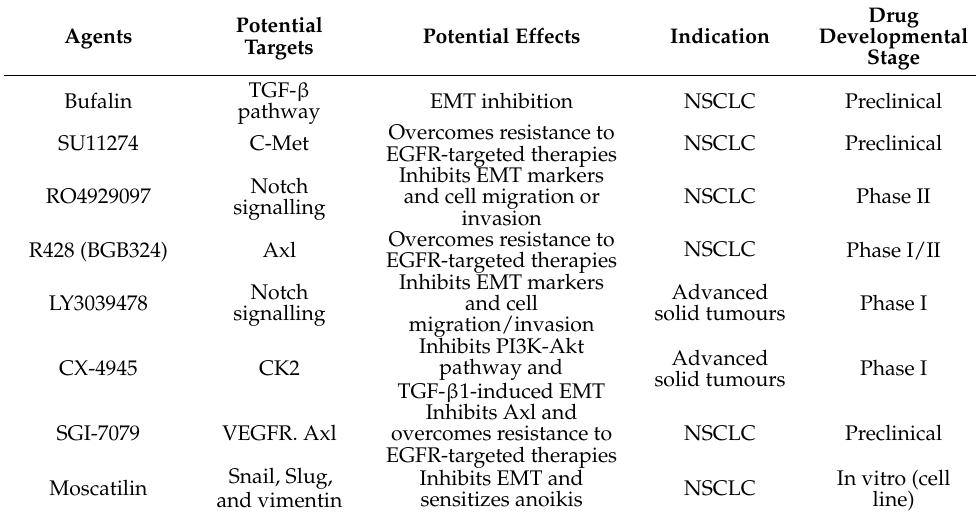
Table 1. Some of the Molecules designed for Targeting EMT in Lung